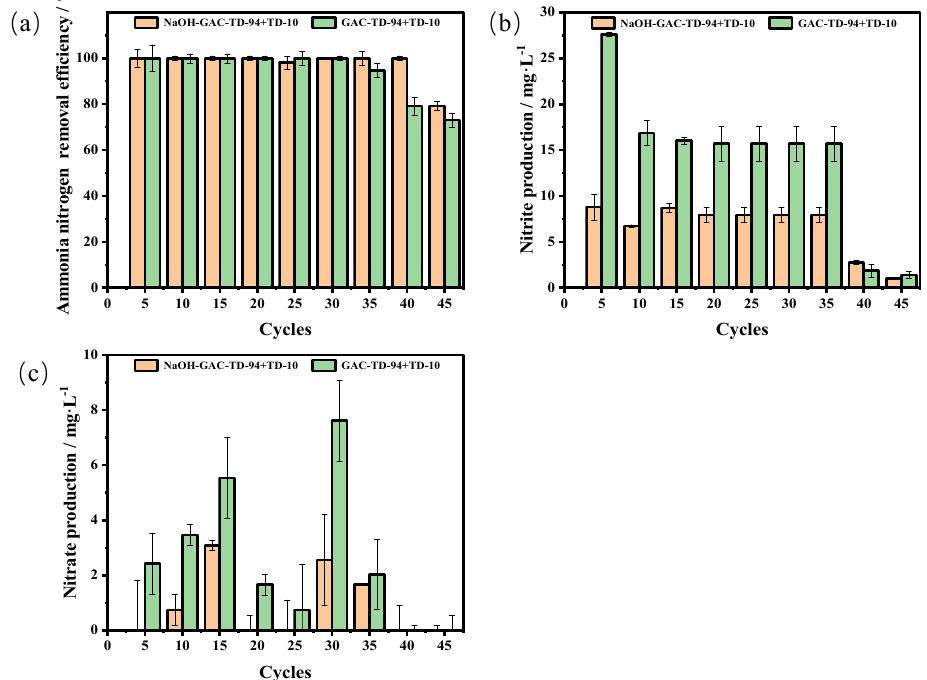
Figure 4. Reusability of immobilized cells. ( a ) Ammonia nitrogen removal efficiency, ( b ) nitrite production, ( c ) nitrate production. (TD-94+TD-10 represents Alcaligenes sp. TD-94 and Paracoccus sp. TD-10).